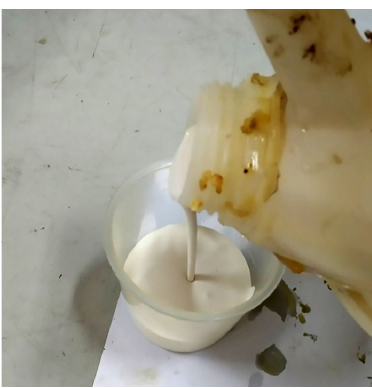
Figure 2. Chemical structure of Liquid Natural Rubber